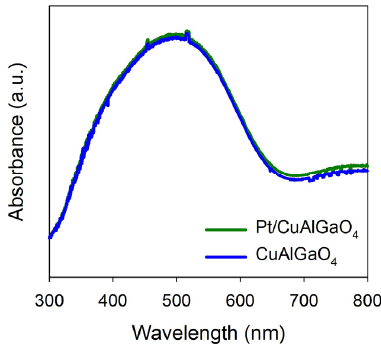
Figure 1. Ultraviolet ‐ visible light (UV ‐ vis) spectra for CuAlGaO 4 and 1 wt % Pt/CuAlGaO 4 photocatalysts.